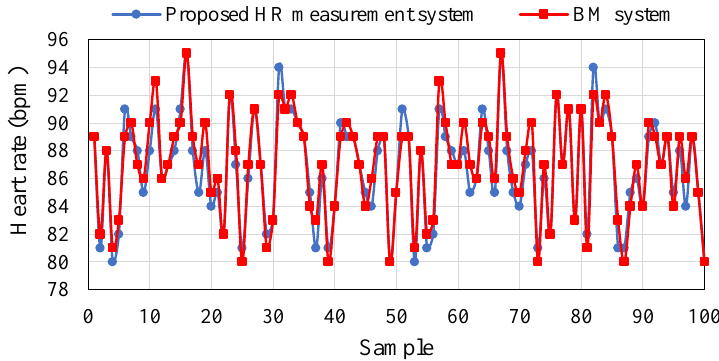
Figure 6. Measurement of WHR and BM systems.